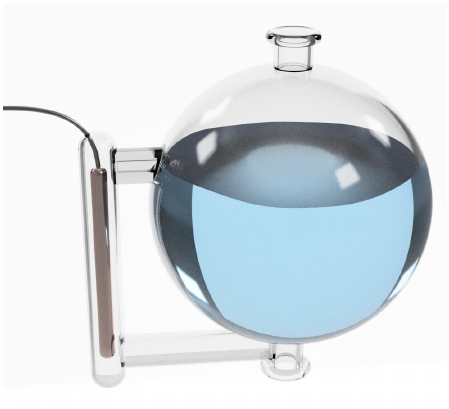
Figure 5. Distillation column